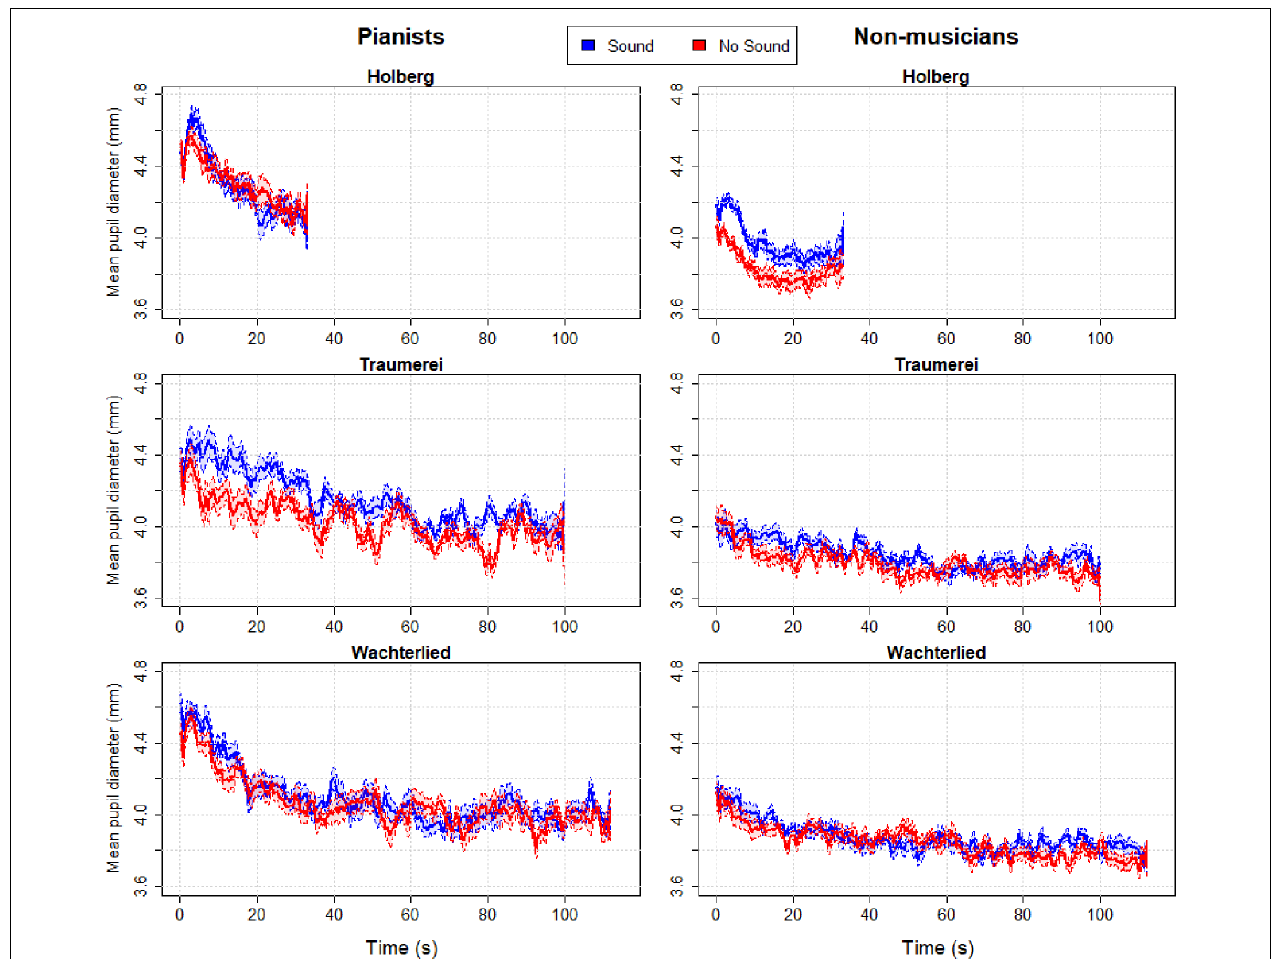
FIGURE 7 | Pupillary waveforms of control participants after averaging the time series of pianists and non-musicians of the three piano excerpts. The two waveforms in each panel illustrate pupillary responses to listening to the two versions of each musical piece, one in which PP played with sound—i.e., standard playing condition (in blue)—and the other while listening to PP playing the same piece but with no sound or silent keys (in red). Patches along the curves indicate between-subjects (95%) confidence intervals.